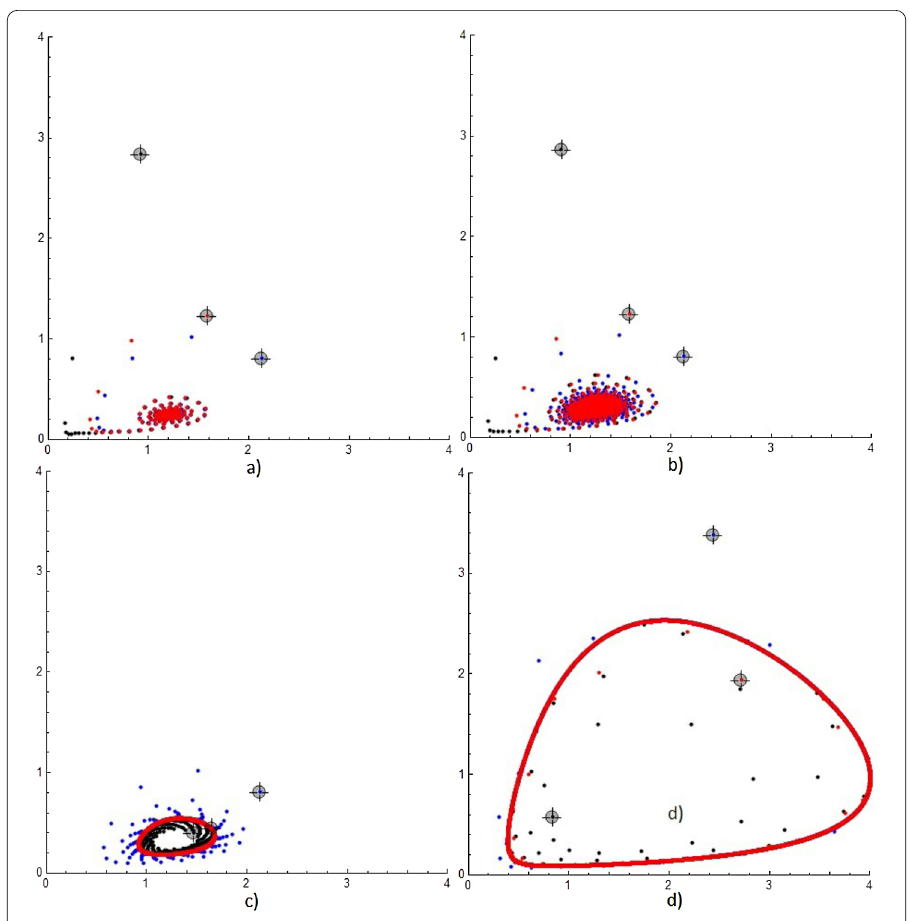
Figure 2 Trajectories (orange, black, and red) for b = 1.05, d = 0.05, m = 1.2, where a 0 ≈ 1.2358, d 2 ( a 0 ) ≈ 0.353405, α 2 ( a 0 ) ≈ –1.20613, ( ¯ x , ¯ y ) = (1.24783,0.3), and a = 4.85, a = 4.92155, a = 4.99, a = 5.22 for model (27) (supercritical Neimark–Sacker bifurcation)